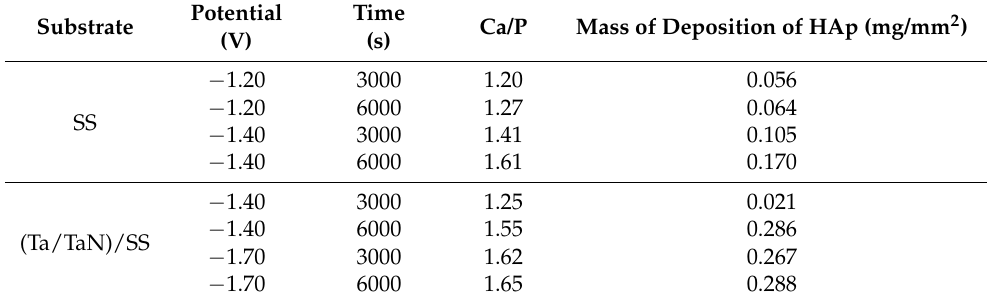
Figure 10. SEM images of HAp deposition on (Ta/TaN)/SS: ( a ) − 1.4 V 3000 s, ( b ) − 1.4 V 6000 s, ( c ) − 1.7 V 3000 s, and ( d ) − 1.7 V 6000 s. Table 2. The ratio of Ca/P and mass of HAp, formed at the different conditions of potential and time, on substrates of SS and